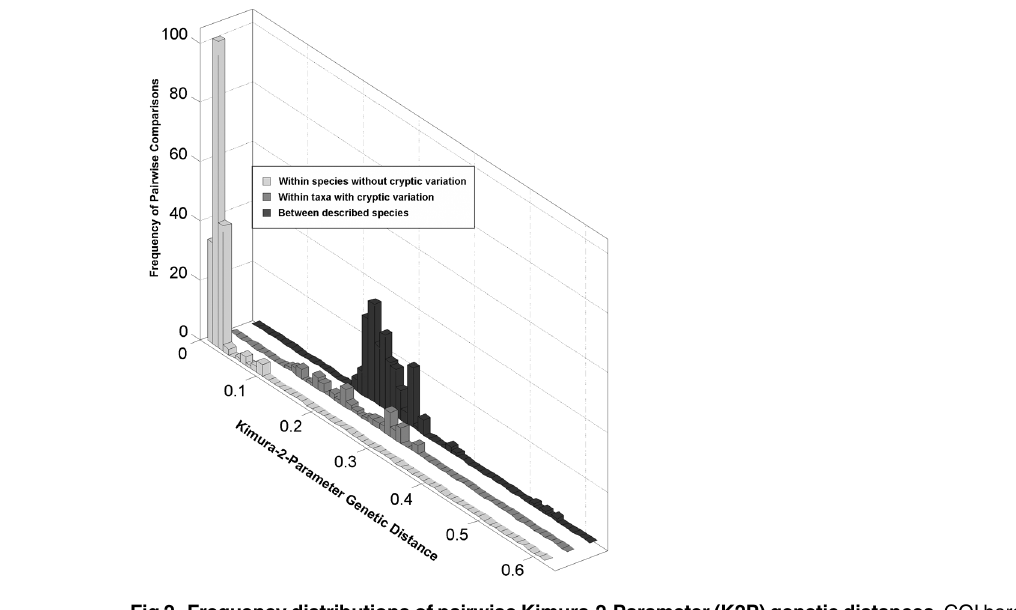
Fig 2. Frequency distributions of pairwise Kimura-2-Parameter (K2P) genetic distances. COI barcode sequences were analyzed to determine frequency distributions of pairwise Kimura-2-Parameter (K2P) genetic distances within and between identified species of halocyprid ostracods analyzed for this study, with separate consideration of taxa (putative species) hypothesized to comprise cryptic species due to large K2P intraspecific distances associated with morphological differences (e.g., presence of different size forms) and/ or genetic differentiation between distinct geographic populations (see text for details). Species of Gigantocypris (Order Myodocopida) were not included in this